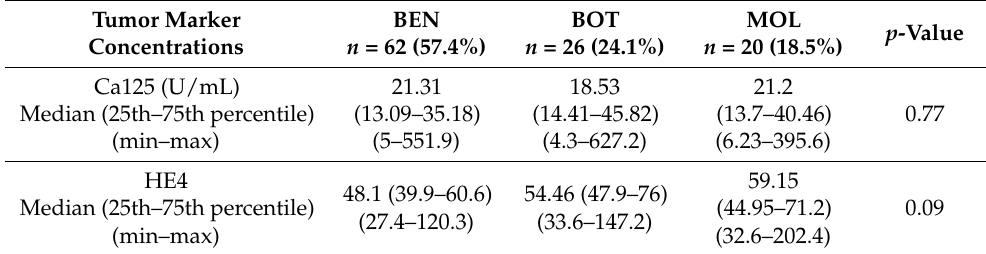
Table 4. CA125 and HE4 concentrations in the studied group of patients.